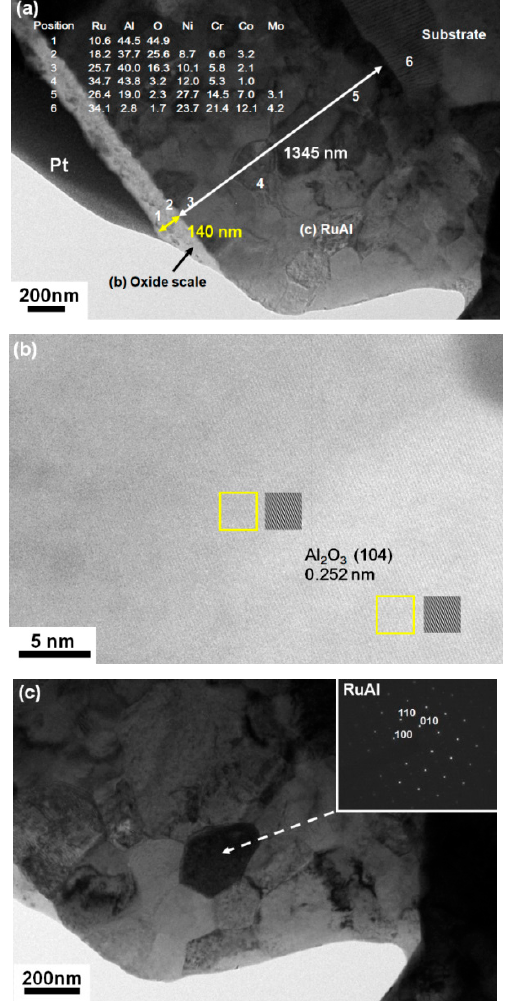
Figure 14. ( a ) Cross-sectional TEM image of the Ru 0.46 Al 0.54 thin films annealed in air at 800 °C for 4 h, ( b ) high-resolution TEM image of the surface oxide scale, and ( c ) a RuAl grain beneath the oxide scale.